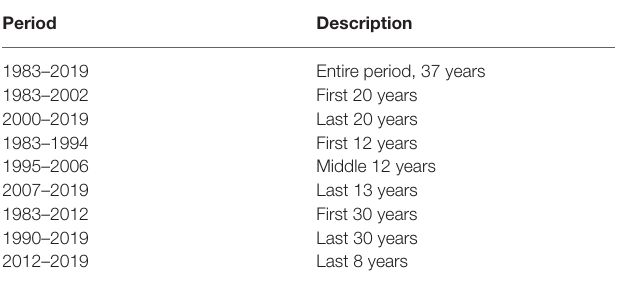
TABLE 2 | Time periods considered in trend